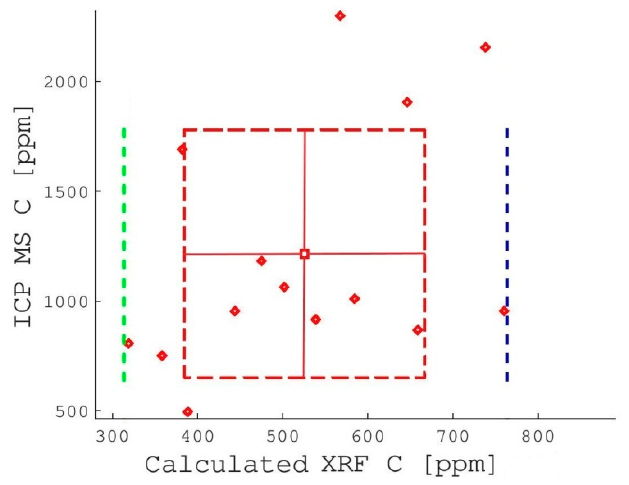
Figure 5. Comparison for the lead content in wall paint, obtained by in situ measurements and ICP ‐ MS tested samples .